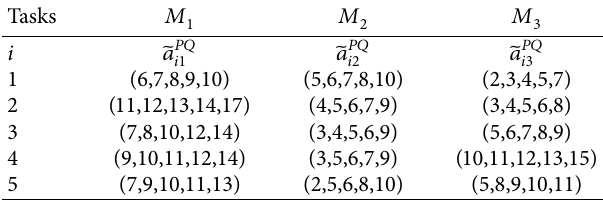
Table 5: PQFN processing times for machines.